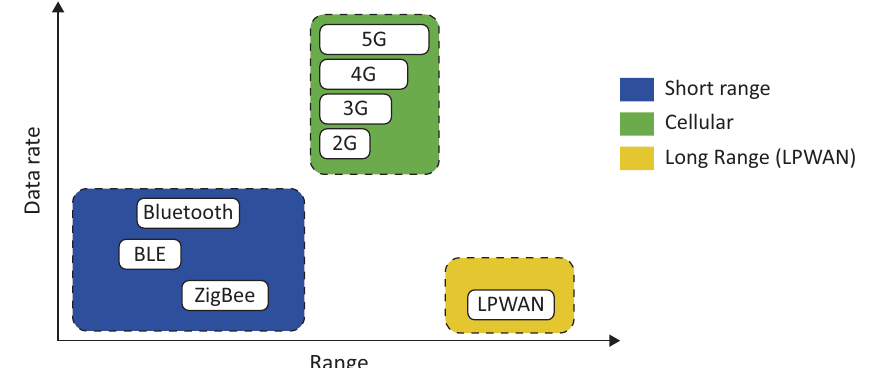
Figure 1. Distinction between different network infrastructures. Source: Hernández (2018). Media and Communication, 2022, Volume 10, Issue 3, Pages